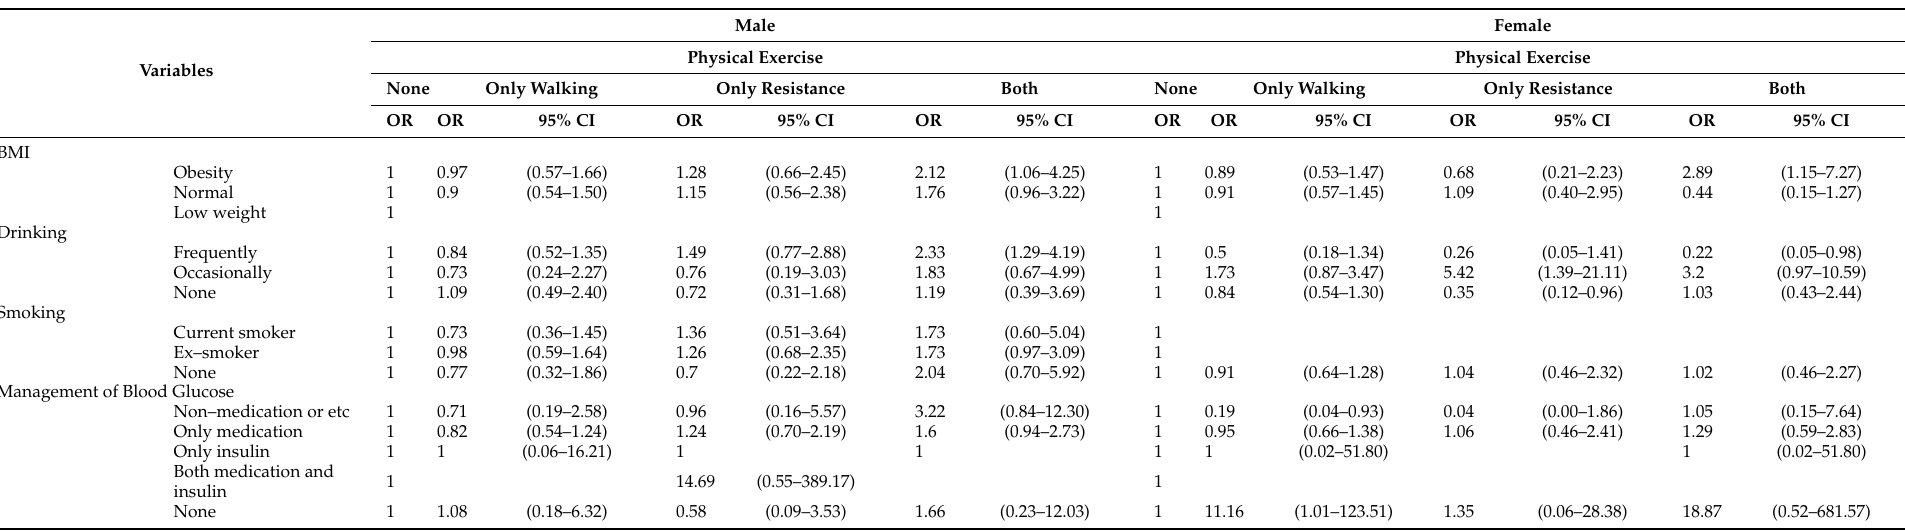
Table 3. Results of subgroup analysis stratified by independent variables related to health status and behavioral